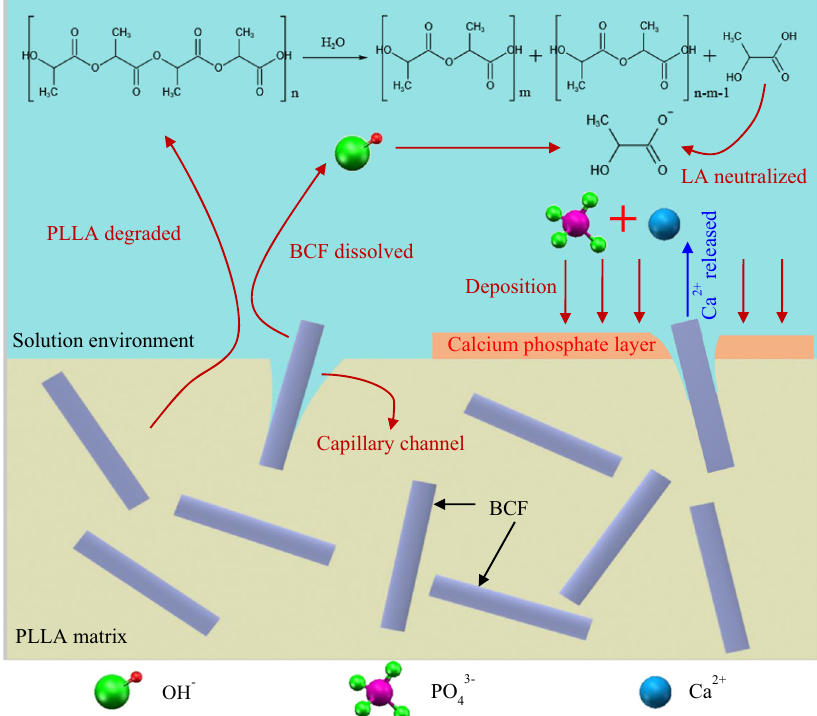
Fig. 4 Mechanism of accelerated degradation and mineralization. The mechanism of accelerating degradation for PLLA matrix and formation of calcium phosphate layer with the introduction of